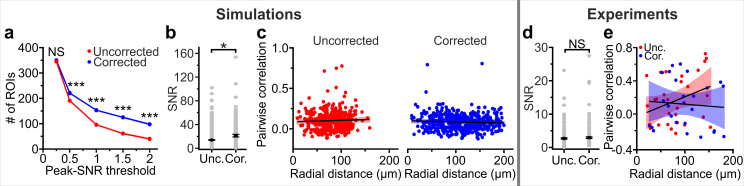
Improved description of neuronal signals in eFOV-microendoscopes is observed in t-series automatically segmented with CaImAn.(a) Number of segmented ROIs as a function of the SNR threshold in artificial data from n = 9 simulated experiments. A two-way ANOVA with interactions showed a significant effect of SNR threshold (p=2E-24). Probe type and interaction effect were not significant (p=0.56 and 0.057 for probe type and for interaction, respectively). (b) Average SNR of calcium signals under the different experimental conditions (SNR threshold = 1 for the automatic CaImAn segmentation). n = 862 and 1378 ROIs in nine simulated experiments with uncorrected and corrected microendoscopes, respectively. Student’s t-test, p=0.01. (c) Pairwise correlation as a function of radial distance for simulated experiments with uncorrected (left) and corrected (right) microendoscopes. Solid lines indicate the linear regression of data and shaded areas represent 95% confidence intervals. n = 413 and n = 464 pairwise correlations for uncorrected and corrected microendoscopes, respectively, from the n = 9 simulated experiments shown in (b). Linear regression fit of data: slope = 1.8E-4, permutation test, p=7E-4 and slope = −1.5E-4, permutation test, p=0.38 for uncorrected and corrected microendoscopes, respectively. (d) SNR of segmented ROIs in in vivo recordings. n = 203 ROIs from 9 FOVs for uncorrected microendoscopes; n = 192 from 6 FOVs for corrected microendoscopes. Student’s t-test, p=0.38. (e) Pairwise correlation as a function of radial distance for in vivo experiments. Number of pairwise correlations: n = 30 from 9 FOVs, n = 26 from 6 FOVs for uncorrected and corrected microendoscopes, respectively. Linear regression fit of data: slope = 0.002, permutation test p=0.042 for uncorrected microendoscopes; slope = −4.7E-4, permutation test p=0.17 for corrected microendoscopes.Figure 4—figure supplement 2—source data 1.Results of automated segmentation: # of ROIs, SNR, and pairwise correlations for simulated and experimental data.